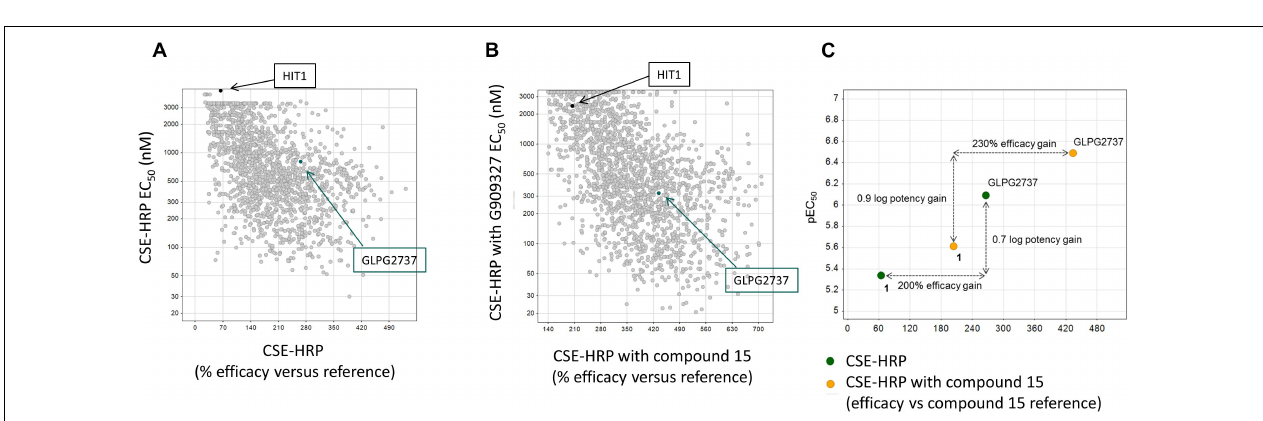
FIGURE 2 | Progression of efficacy ( X -axis) and potency (EC 50 , Y -axis) of corrector series on F508del CFTR, in a CSE-HRP assay. Each dot represents a single compound. Control used in assay corresponds to compound 15 (a lead compound derived from GLPG2222 series, Wang et al., 2018). (A) Effect of compounds on their own on F508del CFTR rescue. (B) Effect of compounds when combined with a C1 corrector (compound 15). Black dot represents the original hit HIT1, the green dot represents GLPG2737. (C) Schematic representation of the shifts in potency and efficacy comparing Hit1 with GLPG2737 both with and without co-corrector